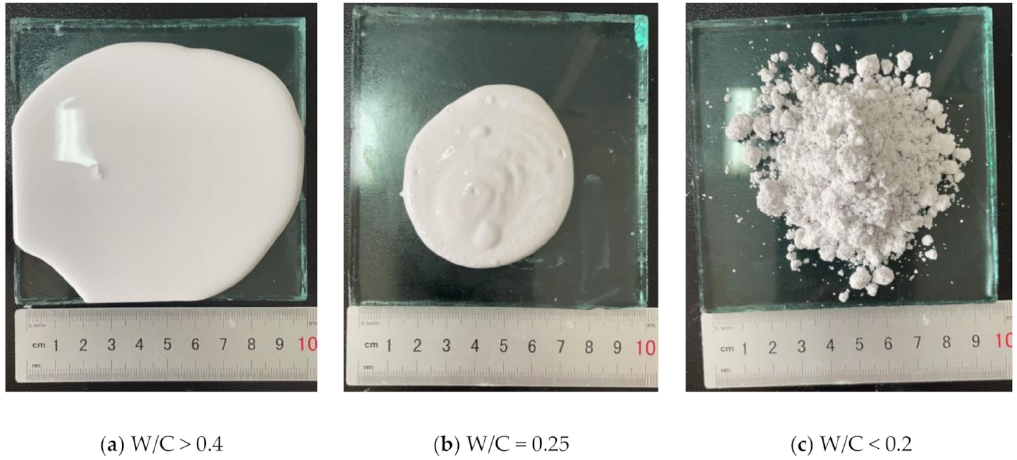
Figure 8. Influence of W/C ratios on the setting performance of